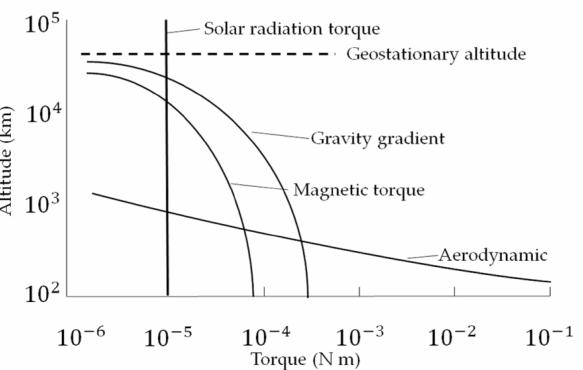
Figure 2. Spacecraft disturbances regarding order of magnitude approximations of external space environment torques as a function of altitude. For LEO (altitudes of <10 3 km), it is apparent that aerodynamic drag is a dominant force. Courtesy of Peter